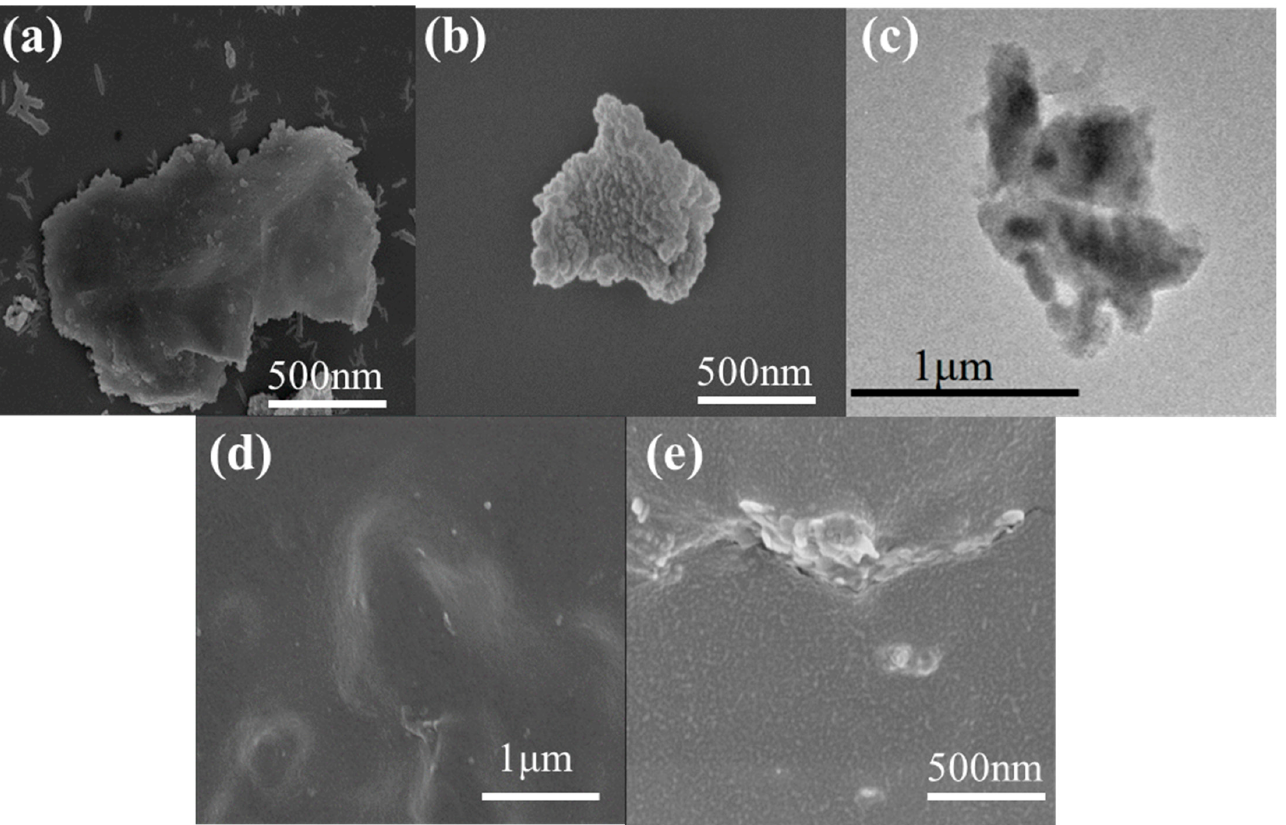
Figure 3. SEM and TEM pictures of ( a ) BNNS, ( b , c ) ZIF-8@BNNS composite materials, and ( d , e ) the surface and cross-section of the ZIF-8@BNNS/Pebax MMM loaded with 20 wt.%.